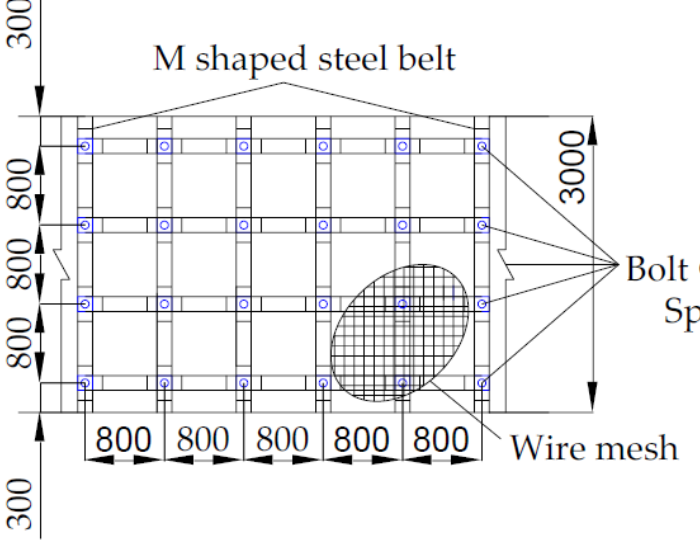
Figure 19. Roof support of return-air roadway in working face 3204.